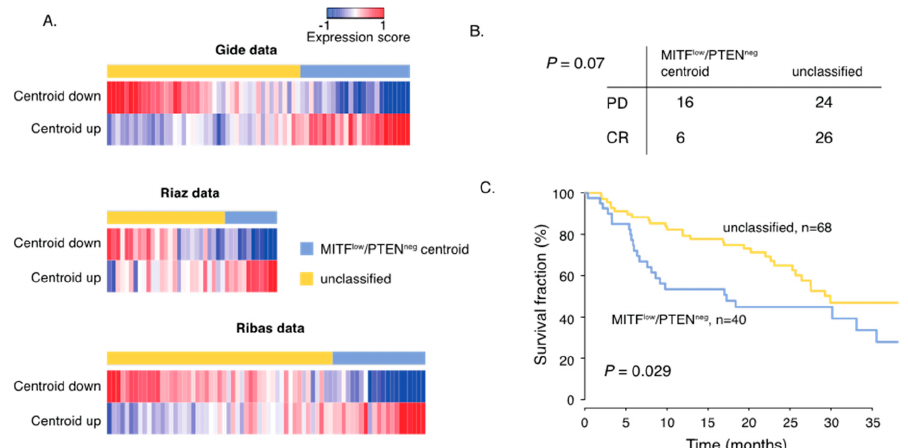
Figure 5. MITFlow / PTENneg gene signature predicts response to MAPK inhibitors and immune checkpoint blockade (ICB). ( A ) Heatmaps display the expression score of the MITF low / PTEN neg centroid (up- and down-regulated genes in the centroid separately) in the ICB and BRAF / MEK inhibitor datasets. ( B ) Response data show the number of patients that developed PD (partial disease) or CR (complete response) to BRAFi / MEKi treatment in the two transcriptional groups. p -values were calculated using Fishers exact test. ( C ) Kaplan–Meier survival analysis using log rank tests of MITF low / PTEN neg tumors and the unclassified group in ICB treated